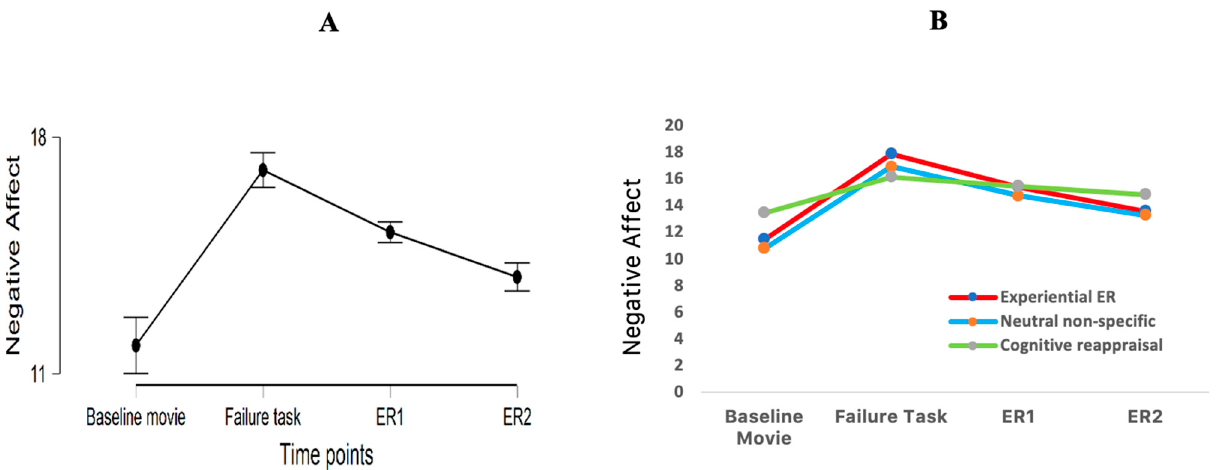
Figure 2. ( A ). Negative affect (NA) reported at different time moments: NA after the baseline movie; NA after the failure task; NA after the first time of emotion regulation (ER1) and NA after the second time of emotion regulation (ER2). ( B ). NA reported at different time moments for each experimental group.